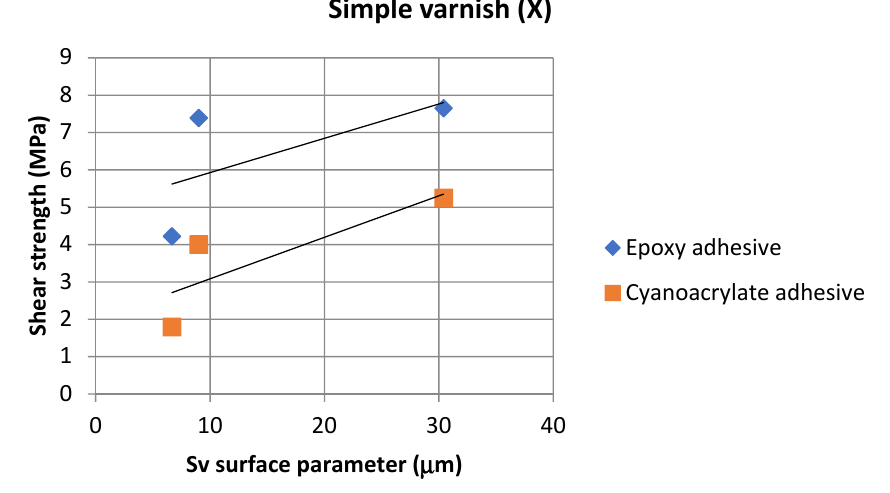
Figure 8. Relations between adhesive joints, shear strength with simple varnish (X), and the Sv surface roughness parameter.